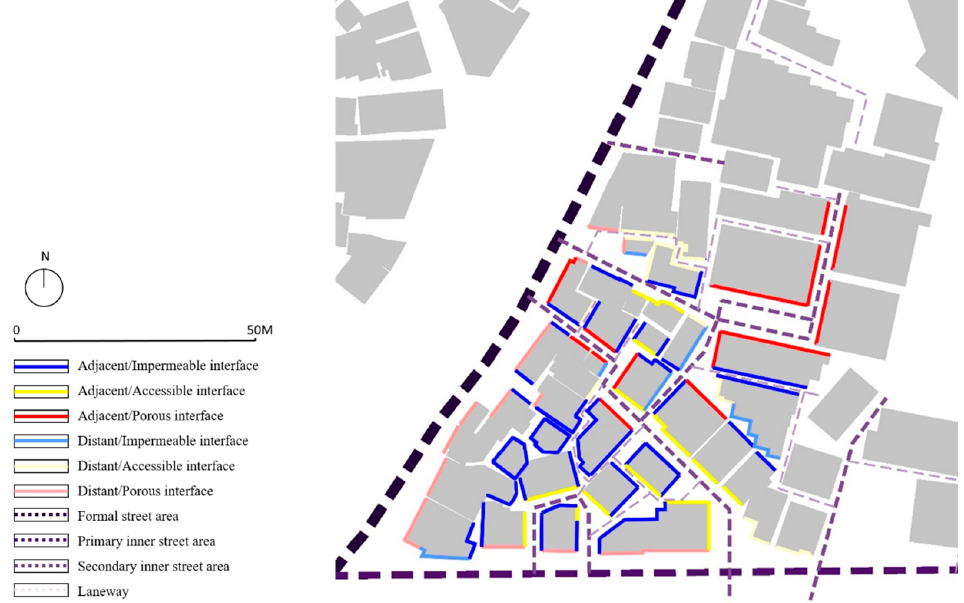
Figure 16. Di ff erent types of interfaces in the studied Figure 16. Different types of interfaces in the studied area. Figure 16. Different types of interfaces in the studied area.